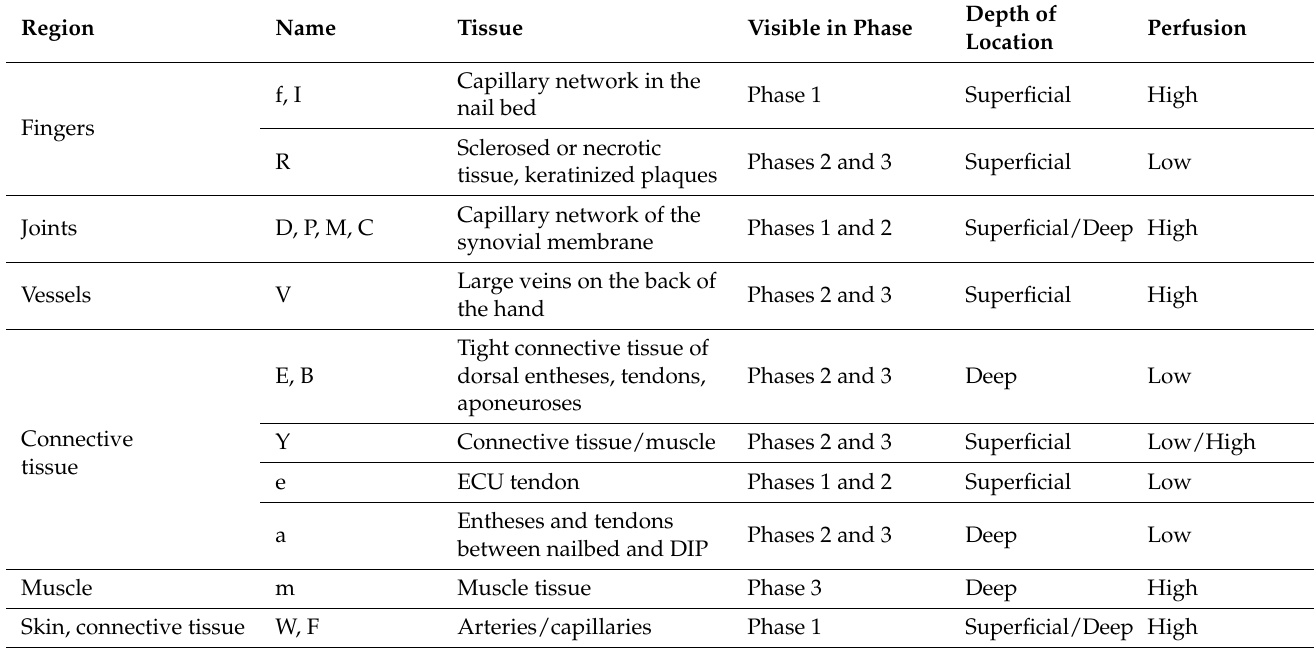
Table 2. Signal distribution pattern in the NIR-FOI of the hands of patients with rheumatic diseases.